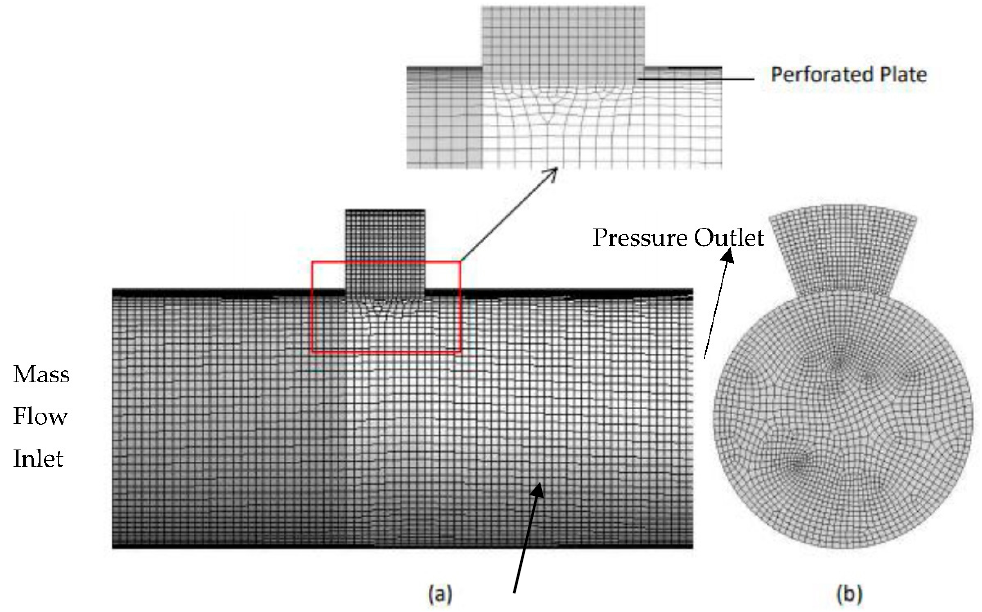
Figure 4. Mesh distribution for CFD simulations employing the PVPM model: ( a ) front view; ( b ) cross-sectional view. The sound sources are two loudspeakers mounted perpendicular to the duct walls.